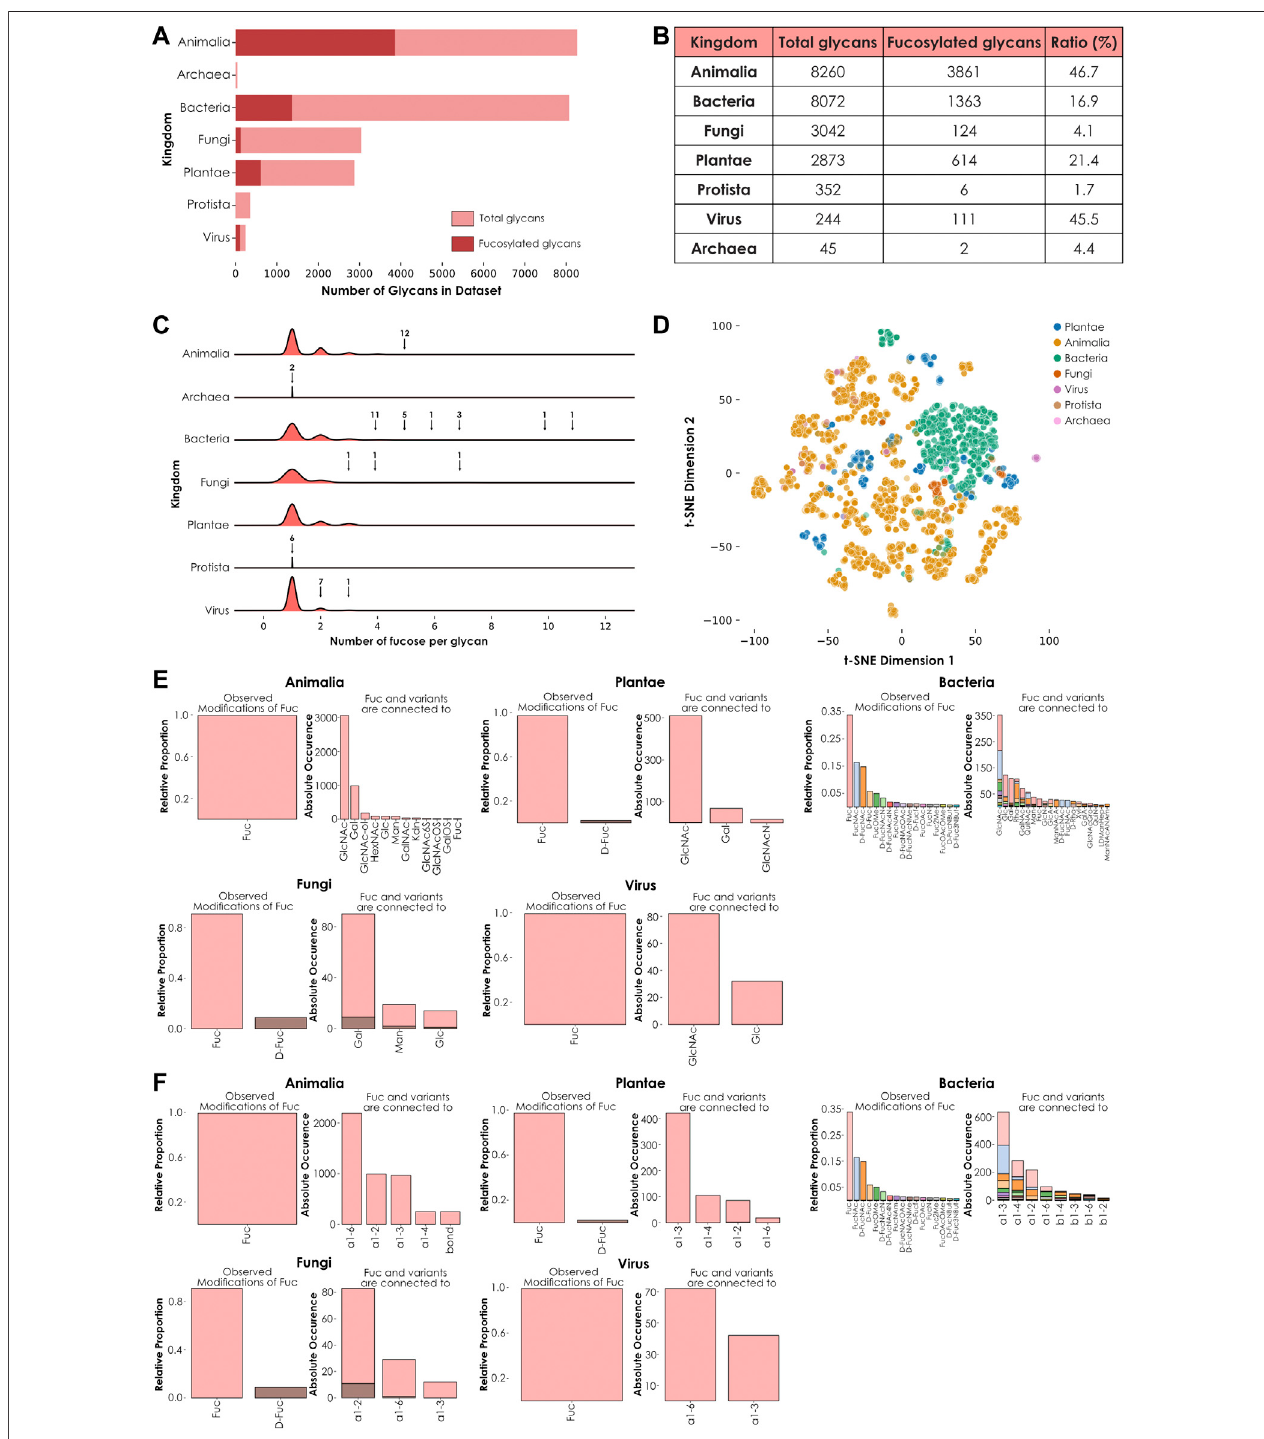
FIGURE 1 | Kingdom-level descriptions of fucose usage. (A) Number of fucose-containing glycans across kingdoms. Total number of glycans available in the datasetforeachkingdomarerepresentedinlightred.Thetotalnumberoffucose-containingglycansisdepictedindarkred. (B) Ratiooftotalversusfucosylatedglycans. Number of total and fucosylated glycans from the seven investigated kingdoms are ordered by decreasing number of total glycans. The ratio of fucosylated glycans is indicated as a percentage. (C) Fucose enrichment in glycans. This joyplot shows, for each kingdom, the number of fucose units per fucose-containing glycan. Arrowsindicate peaks correspondingtofucosylatedglycanspresent in toolowproportions tobe visibleand theirassociatednumber ofglycans. (D) Diversity offucose- containing glycans across kingdoms. Fucose-containing glycans from every species in the dataset are represented as colored dots via t-SNE, based on their learned